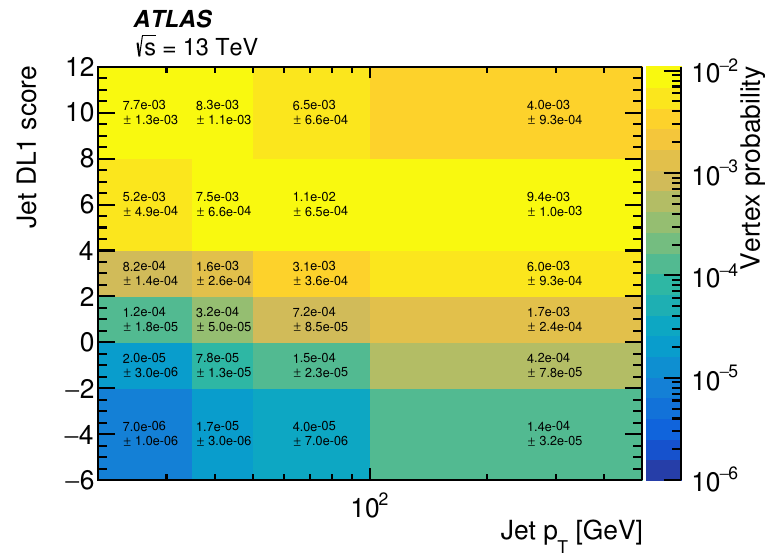
Figure 3 . The per-jet DV probabilities computed in the CR, as a function of jet p T and DL1 b -tag score. The rightmost column of bins is inclusive and includes jets with p T > 500